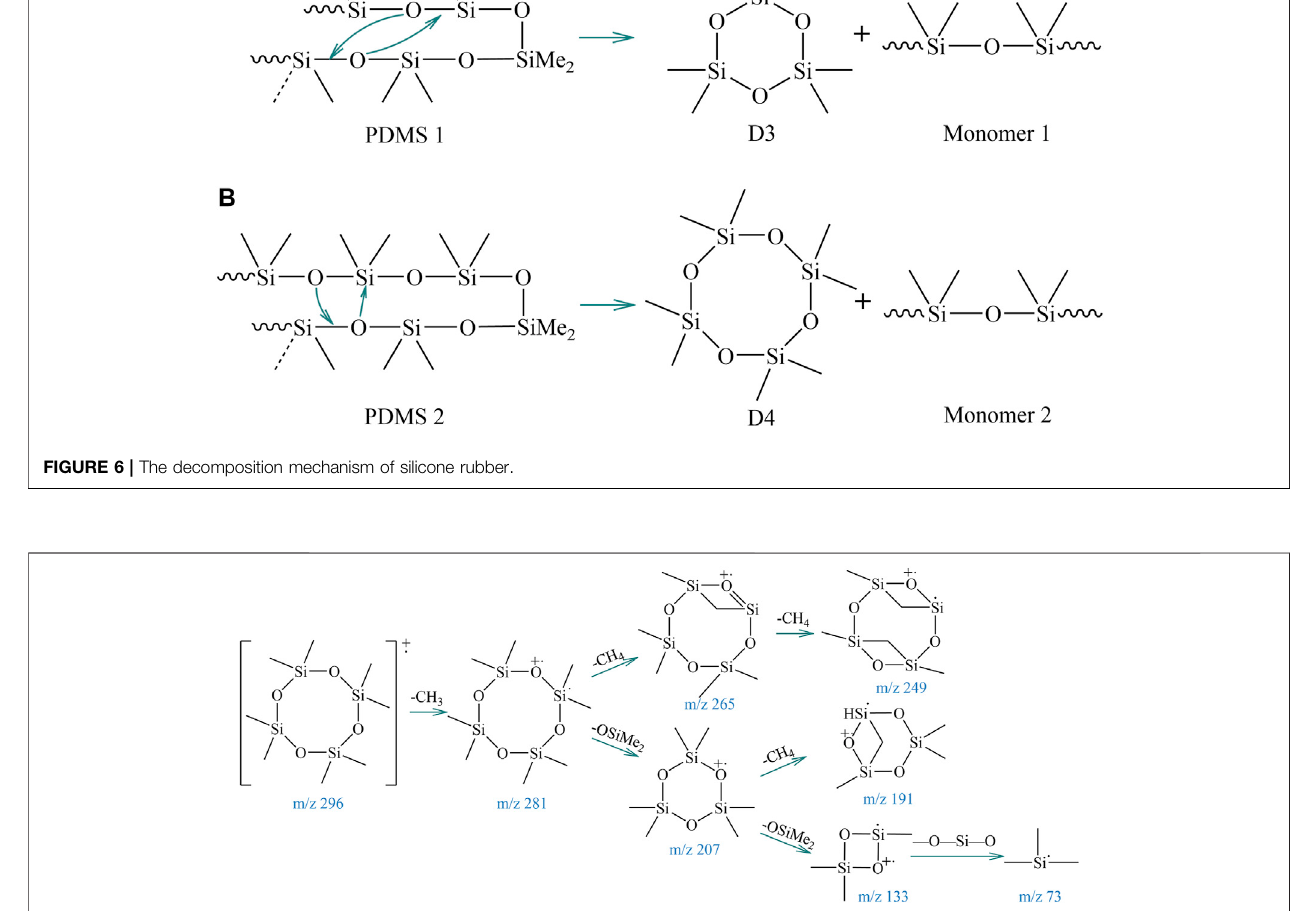
FIGURE 7 | The main biodegradation mechanism of D4 and D3.